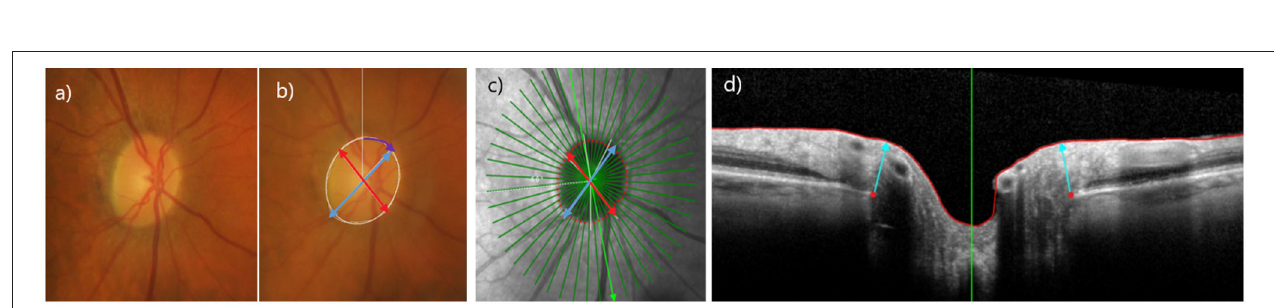
FIGURE 1 | Delineation of semi-automated measurement of ovality index and rotation angle from photographs. (a) Stereophotograph of a glaucomatous mild myopic eye, (b) Clinical disc margin manually delineated in white, (c) Best-fitted ellipse overlaid in white. Ovality index is calculated as the minor axis (green) divided by the major axis (blue). Rotation angle ( θ v blue arrow) is defined as the angle between the vertical axis (yellow) and major axis (blue).